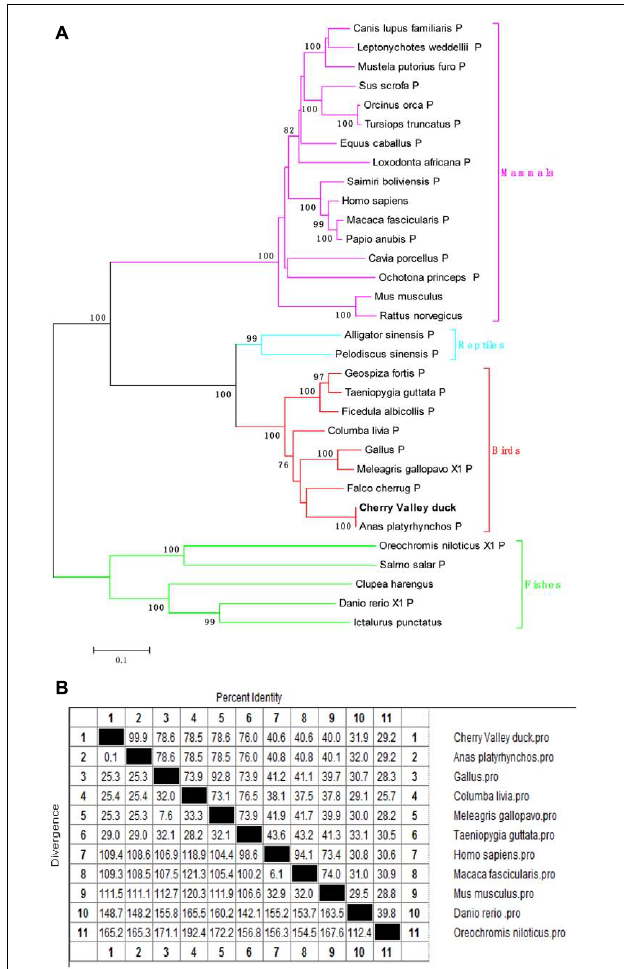
FIGURE 2 | (A) A phylogenic tree based on CIITA between Cherry Valley duck and other species amino acid sequence. Neighbor-joining tree was generated using MEGA 5.0, and a 1000 bootstrap analysis was performed. The scale bar was 0.1. GenBank accession numbers were shown in Table 2 . (B) Homology analysis of Cherry Valley duck CIITA in amino acid sequence (% amino acid sequence identities). Percent amino acid sequence homology